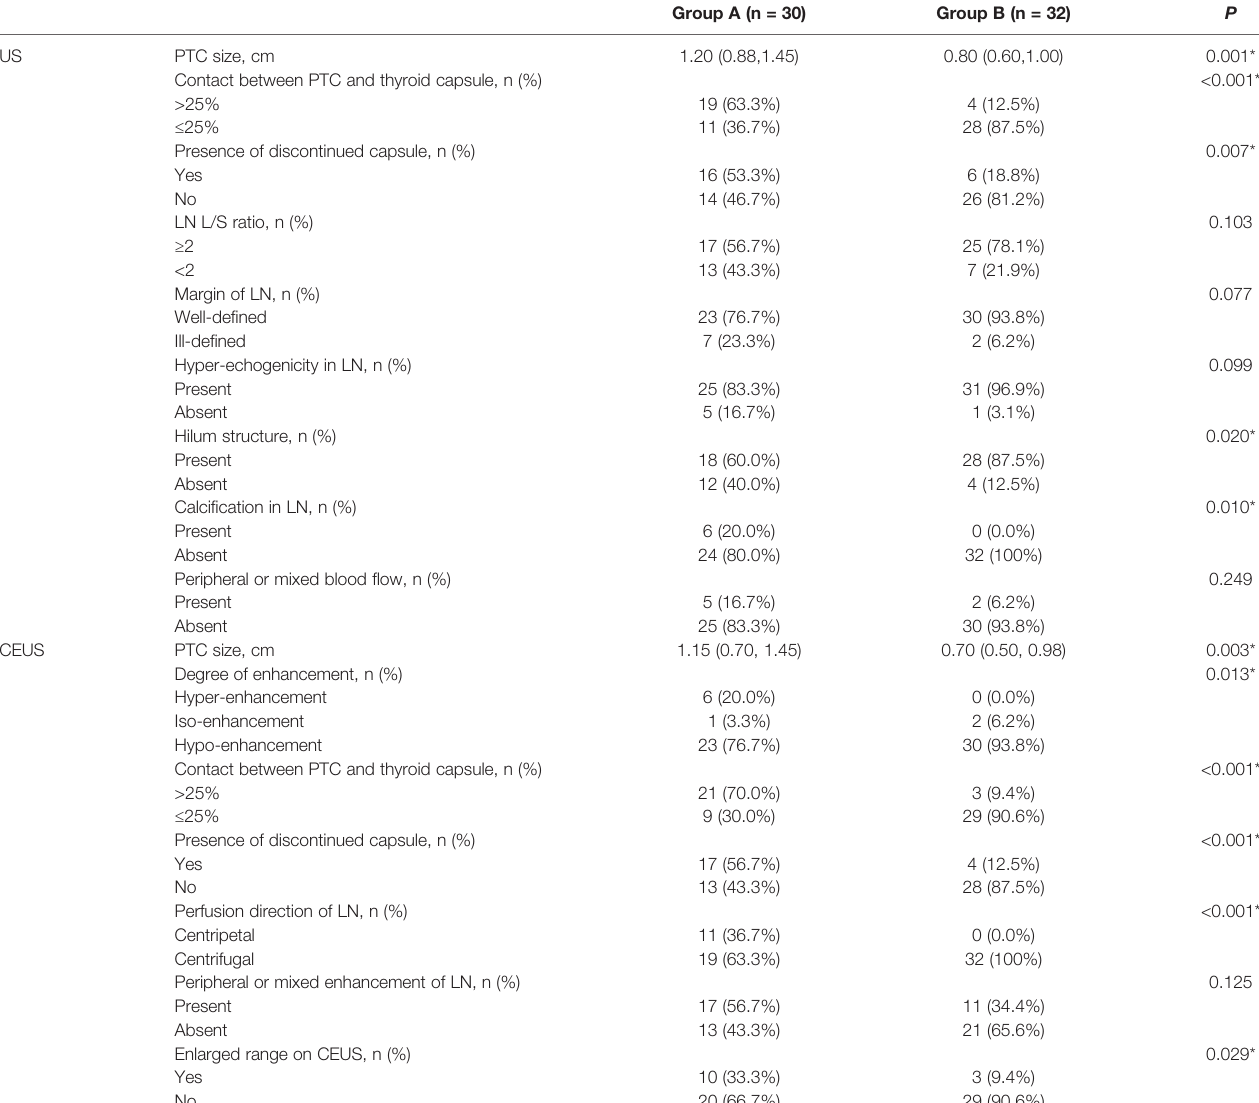
TABLE 1 | US and CEUS features of PTCs and lymph nodes in the two